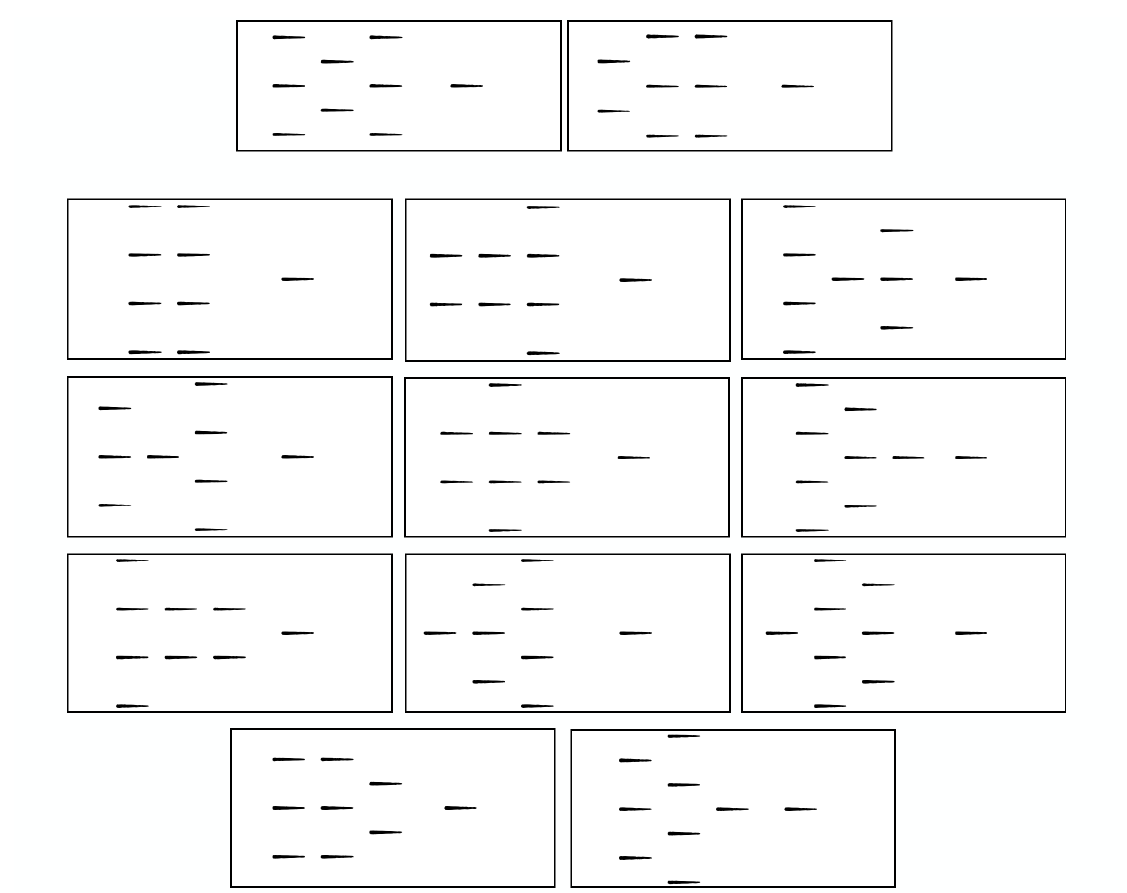
Figure A7. Configurations for eight leading